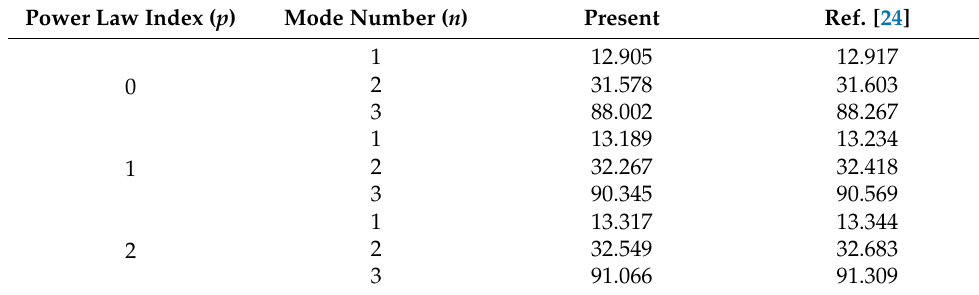
Table 2. A comparative study of the natural frequencies of an FG cylindrical shell.